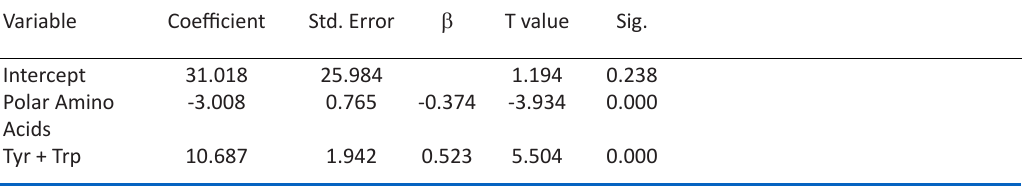
Table 6. Multiple regression analysis of polar and aromatic amino acids for optimal temperature prediction Variable